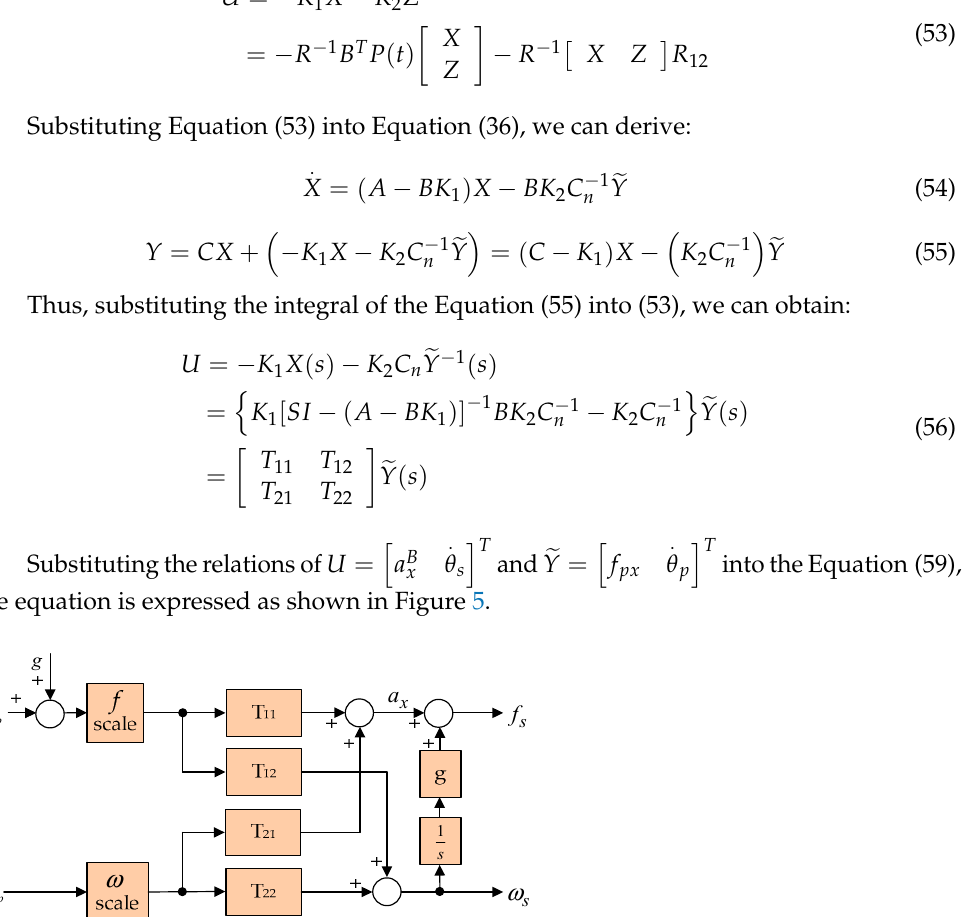
Figure 5. The block diagram of optimal control algorithm.